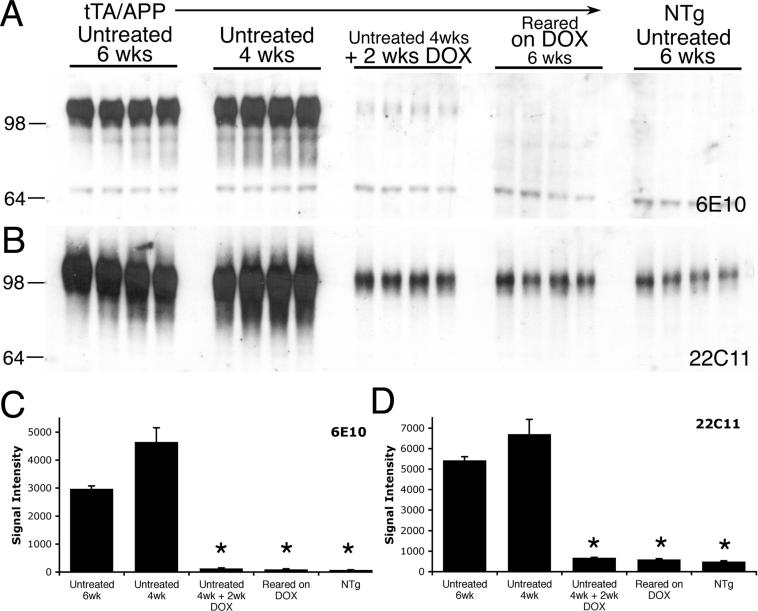
Control of Transgenic APP Expression by Dox(A) Western blotting for transgenic APP using the human-specific 6E10 antibody shows expression of full-length protein in forebrain tissue from young predeposit double transgenic animals (line 107) and its suppression following dox treatment. Untreated animals show high levels of transgene expression; protein levels drop dramatically in animals acutely treated with dox for 2 wk. A faint, but detectable band of full-length protein remains in acutely treated animals that can be eliminated in mice born and raised on dox.(B) Immunoblotting with the N-terminal antibody 22C11 to detect both transgenic and endogenous protein shows that dox treatment reduces APP/APLP to levels found in nontransgenic mice.(C) Measurement of signal intensity from the Western blot in (A) shows transgenic APP levels are decreased more than 95% by dox in both acutely and chronically treated animals (97.2% for 4 wk + 2 wk dox, 98.0% for reared on dox versus 4 wk untreated; ANOVA effect of treatment group F
4,15 = 85.55, p < 0.001). APP levels in 4 wk + 2 wk dox, reared on dox, and nontransgenic (NTg) were not significantly different (p > 0.9, Tukey post-hoc test).(D) Measurement of signal intensity from the Western blot in (B) shows total APP/APLP levels in dox-treated tTA/APP mice are significantly lower than in 4-wk-old untreated mice (ANOVA effect of treatment group F
4,15 = 84.41, p < 0.001) and indistinguishable from those of nontransgenic animals (p > 0.9, Tukey post-hoc test). *, p < 0.001 versus untreated 4-wk-old mice, Tukey post-hoc test applied to significant effect of group ANOVA.